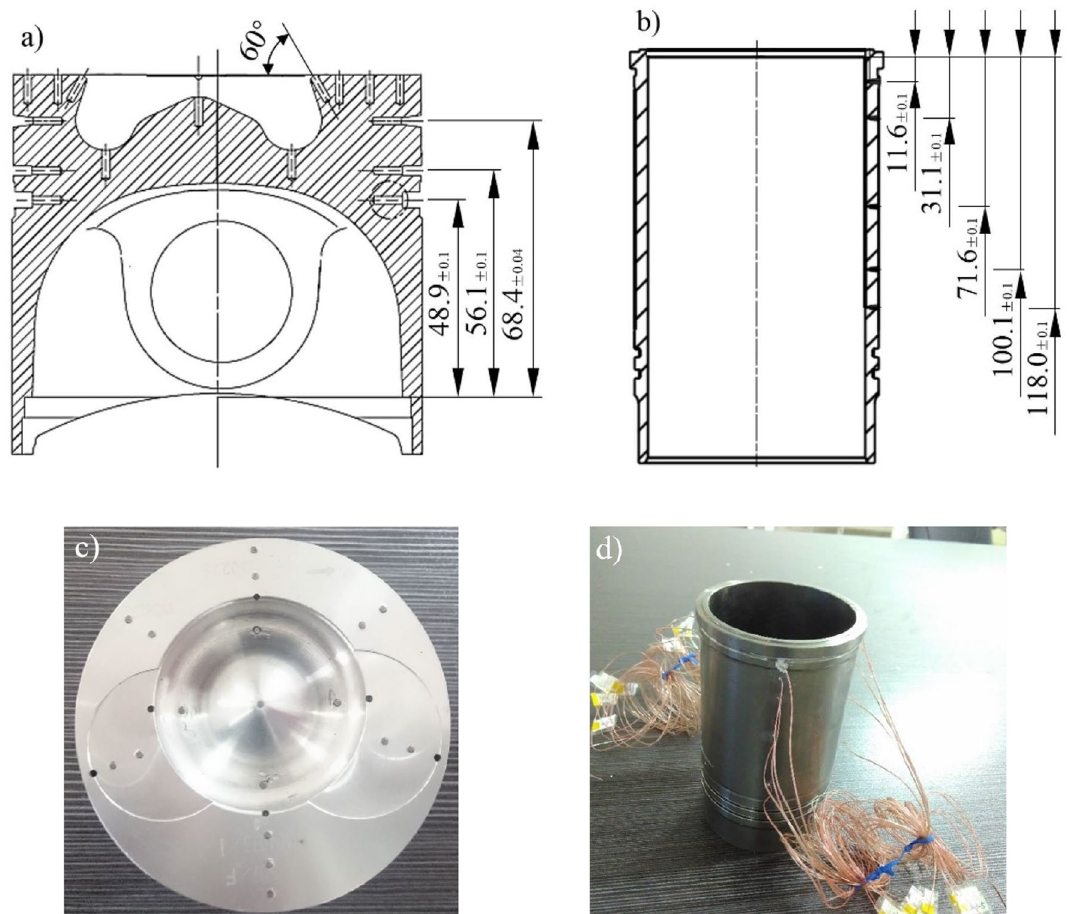
Figure 3. Temperature measure locations distribution of ( a ) piston, and ( b ) liner. Test objects of ( c ) piston, and ( d )